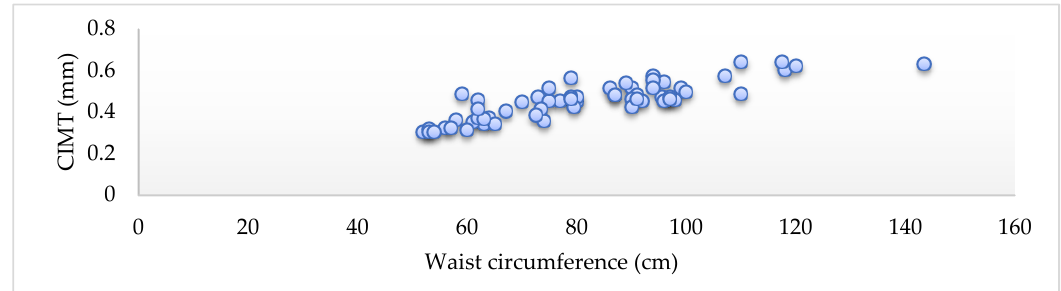
Figure 6. The correlation between waist circumference and CIMT values.